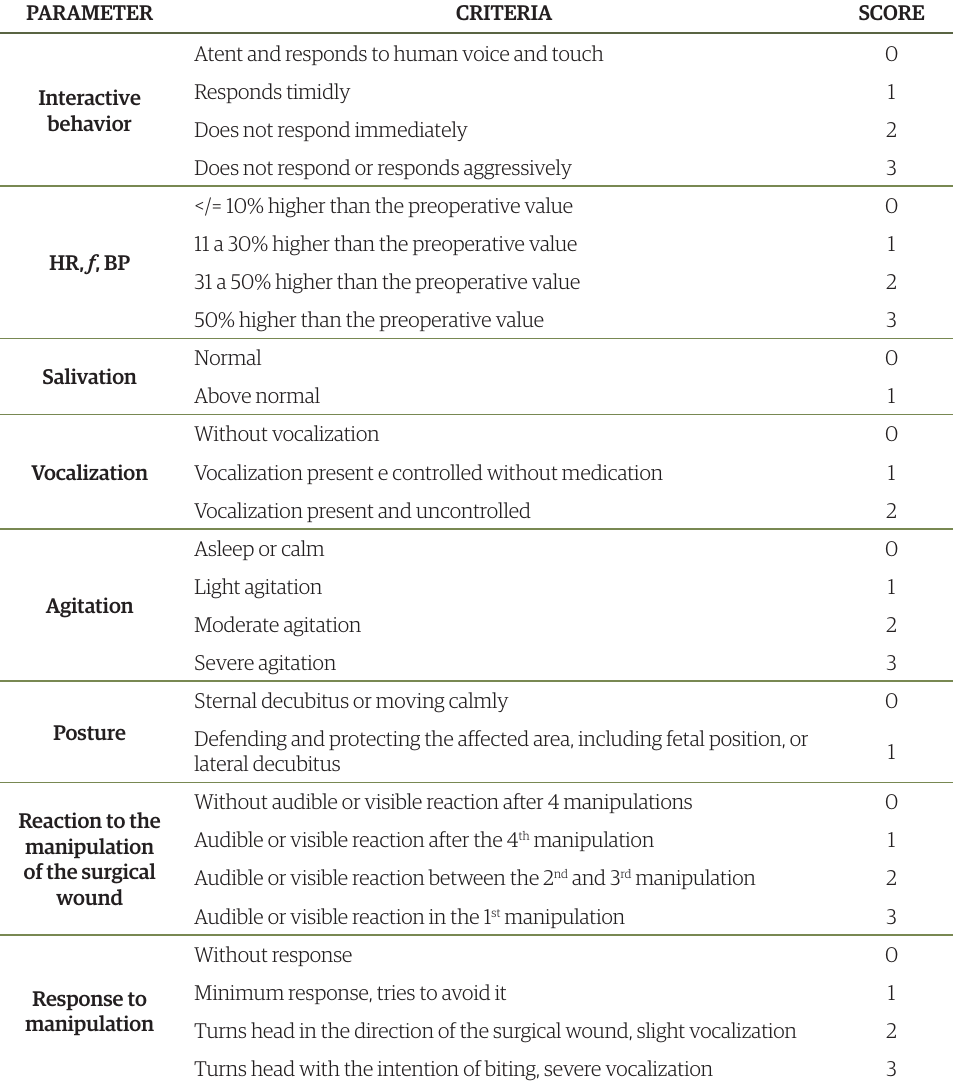
Table 1. Criteria for the assessment of the level of analgesia.